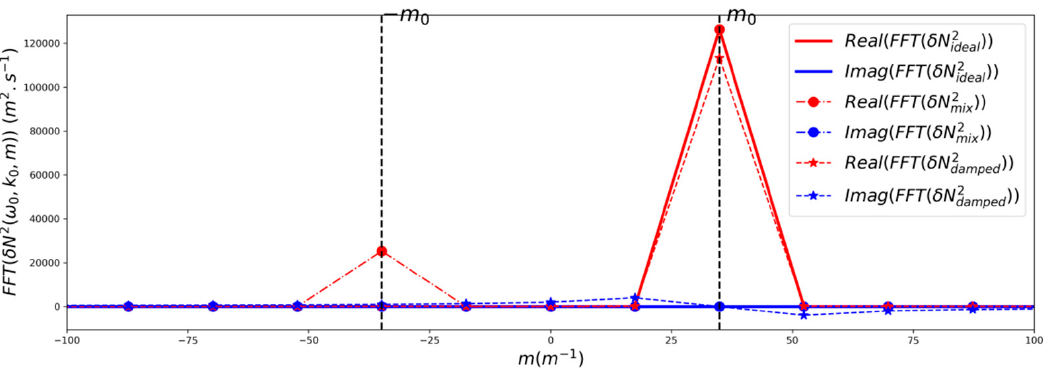
Figure 2. Spectra of δ N 2 (solid lines), δ N 2 (dashed lines with star markers) and δ N 2 mix ideal damped (dashed-dotted lines with circle markers) as a function of m for k = k 0 and ω = ω 0 . Blue lines: imaginary part; red lines: real part.